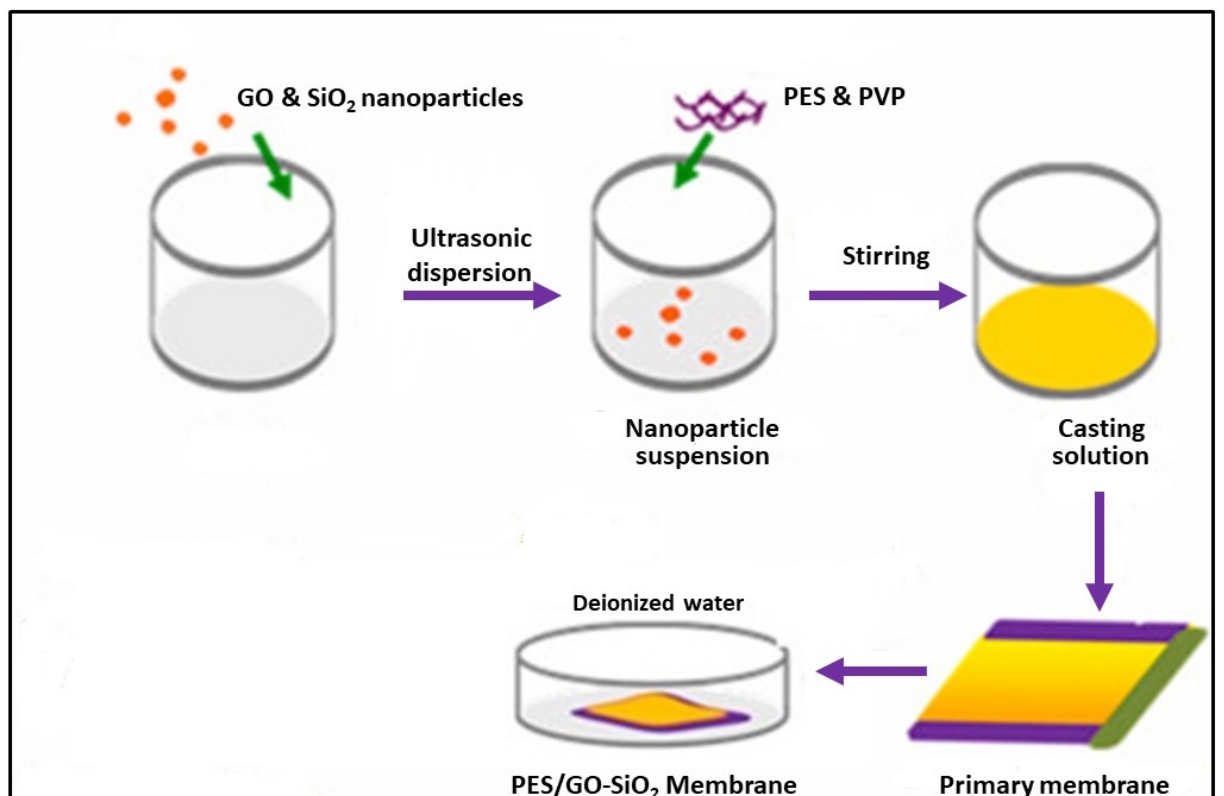
Figure 6. Schematic diagram of preparing polyethersulfone/graphene oxide-silicon dioxide (PES/GO-SiO 2 ) membrane using phase inversion technique.